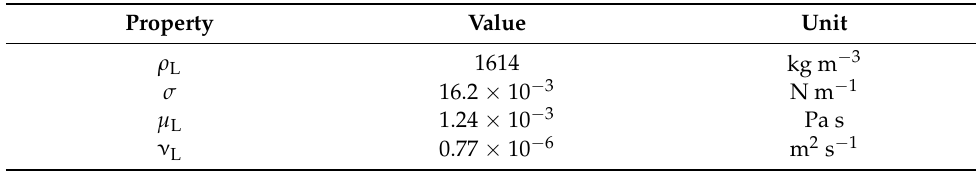
Table 2. Characteristics of liquid HFE-7500 at 25 ◦ C.